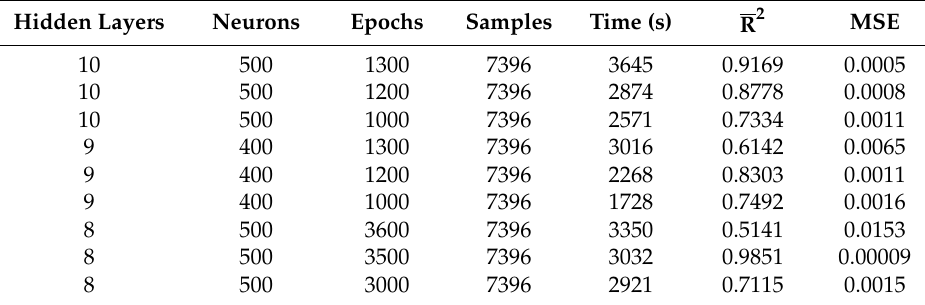
Table 3. Parameters and Results of Model II.